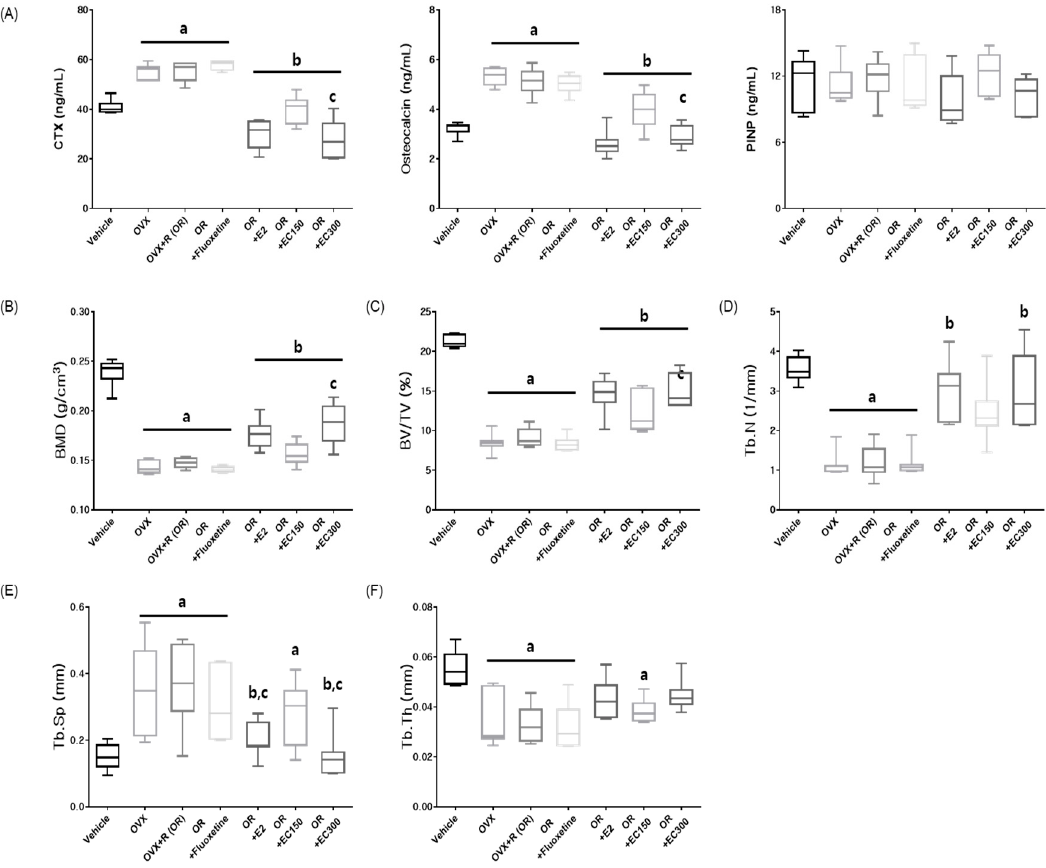
Figure 3. Effects of EC extract on the serum bone biomarkers and bone mineral density. Bone metabolism markers ( A ) CTX, osteocalcin, and PINP. ( B ) Bone mineral density (BMD), ( C ) percent bone volume (BV/TV), ( D ) trabecular separation (Tb.Sp), ( E ) trabecular thickness (Tb.Th), and ( F ) trabecular number (Tb.N) were photographed by micro-CT, and data were evaluated using analyzing software (CTan). a p < 0.05 vs. vehicle group. b p < 0.05 vs. OVX. c p < 0.05 vs. OR.